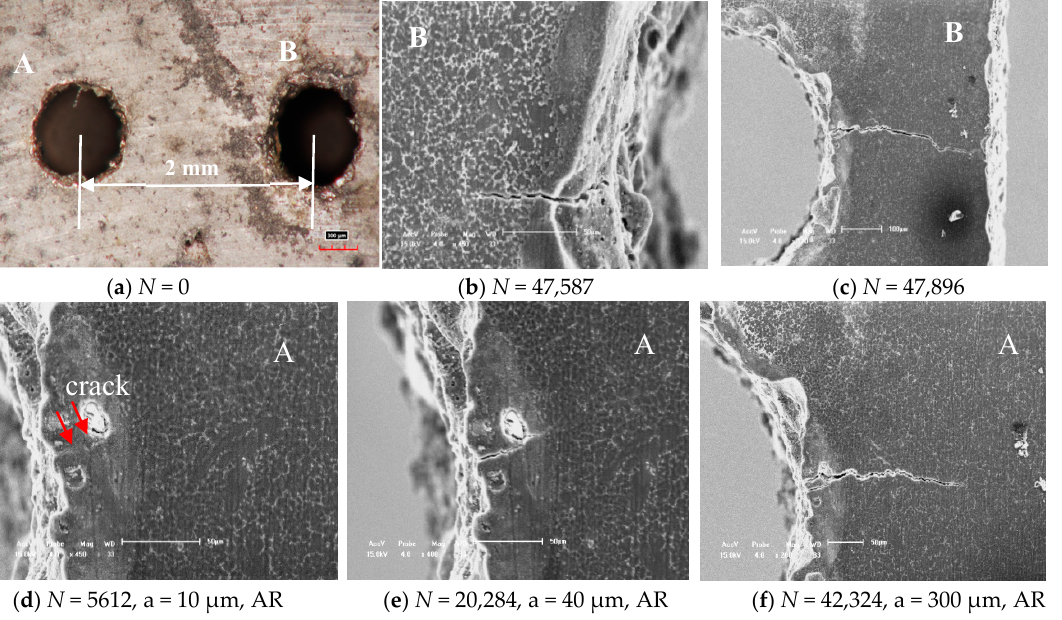
Figure 7. Effect of 90° titled and distance 2.0 mm of two through holes on the fatigue crack initiation and propagation of cast AZ91 alloy at the maximum stress level of 100 MPa, R = 0.1.